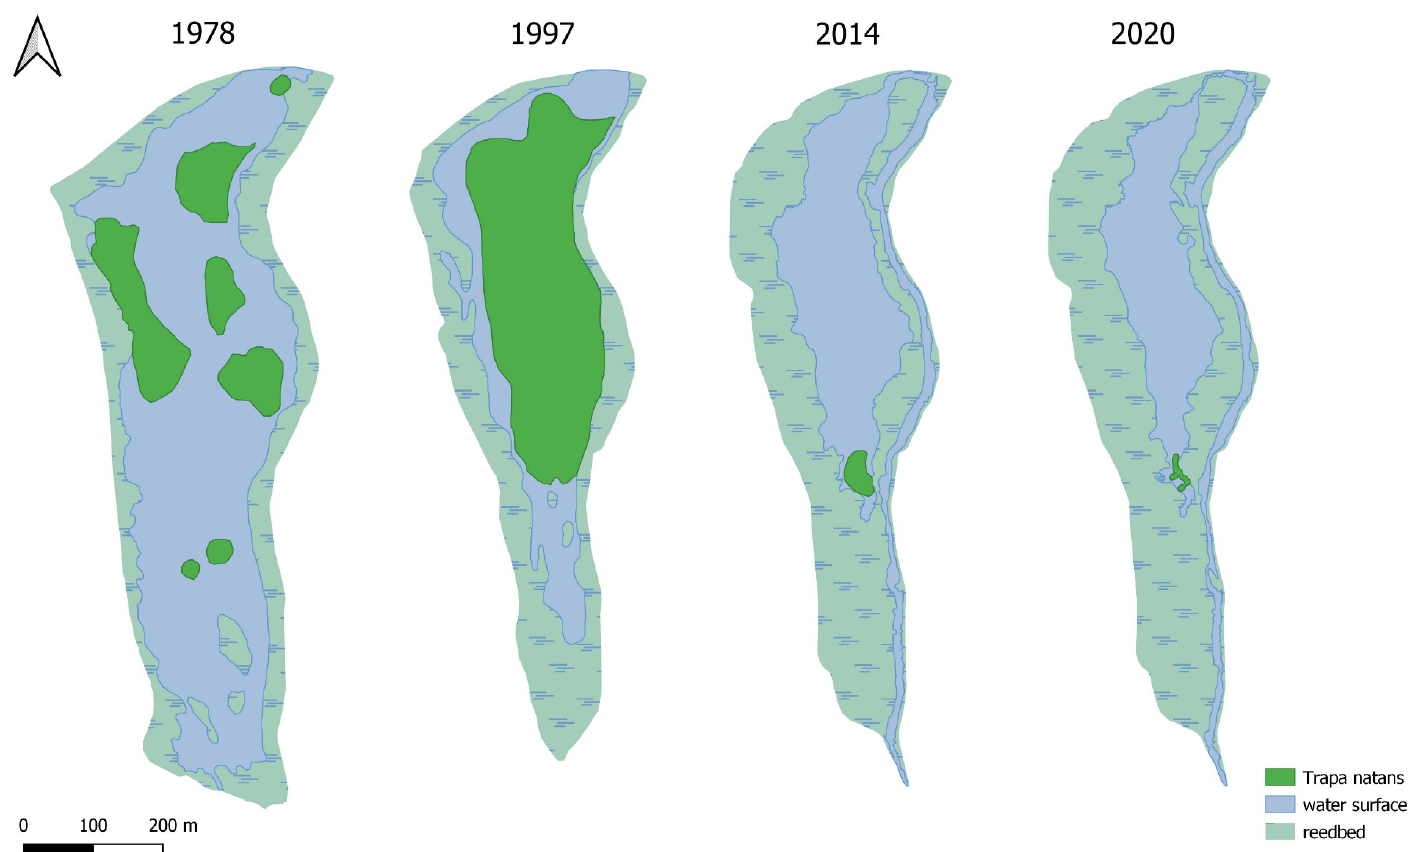
Figure 3. Changes in time of the T. natans distribution in the Nowoku ź nicki pond.